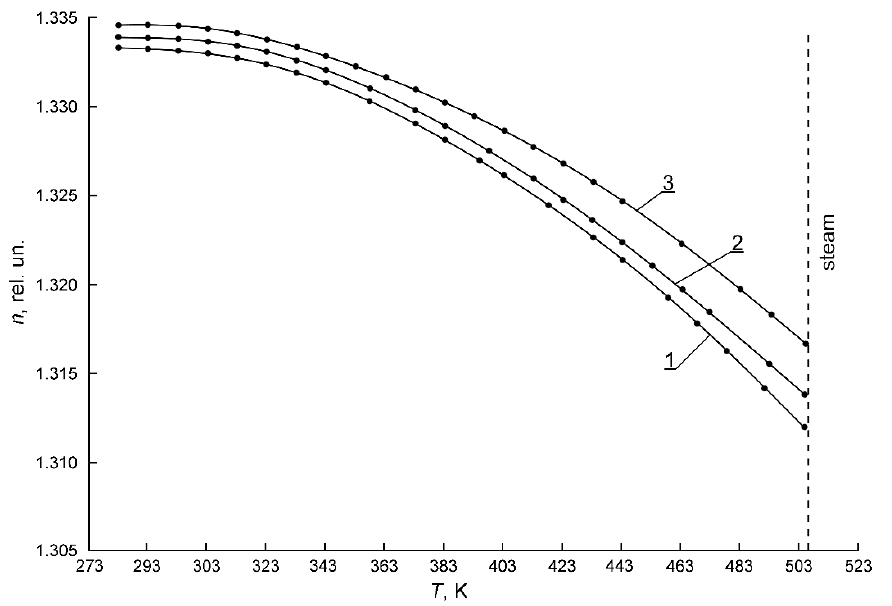
Figure 3. Dependence of the refractive index n on the temperature T . Graphs (1–3) correspond to the following media: distilled water, feed water and tap water.